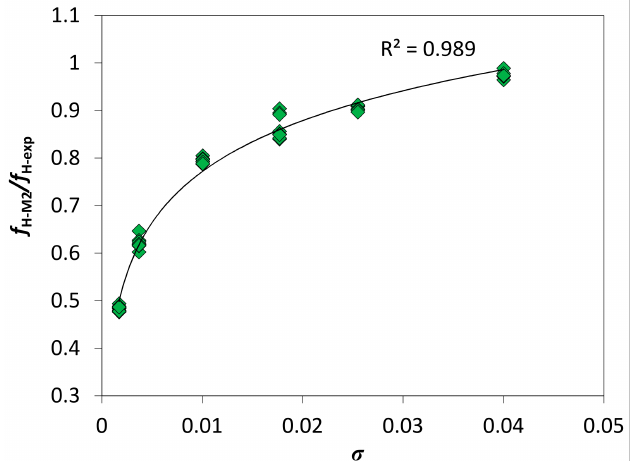
Figure 12. The f H-M2 / f H-exp ratio as a function of parameter σ (dl-7/V-1—dl-12/V-9).